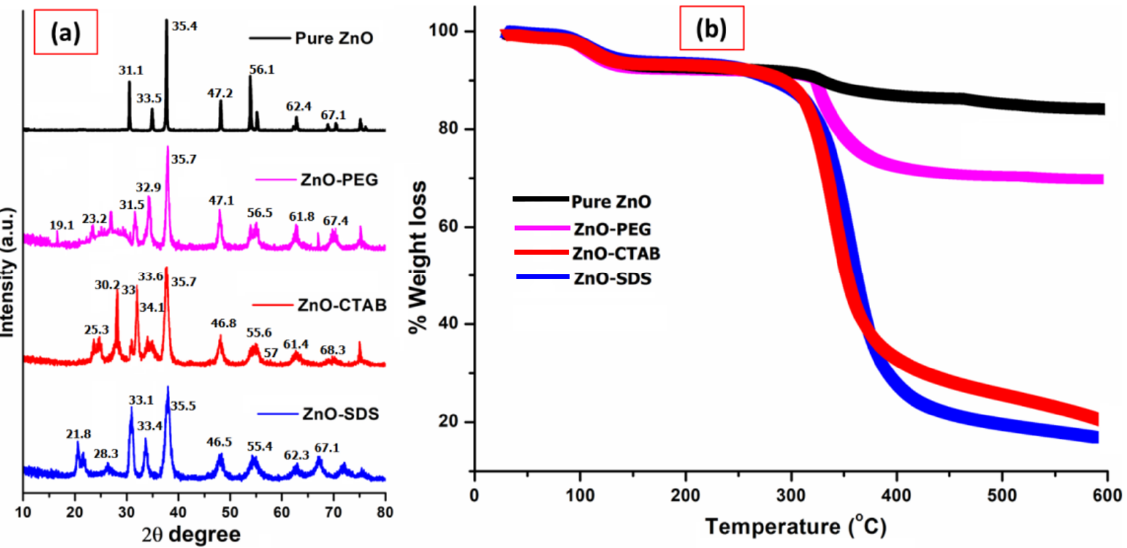
Figure 2. Comparison of ( a ) powdered XRD patterns and ( b ) TGA studies of all four ZnO NPs. The XRD pattern of ZnO–CTAB shows an increase in the diffraction peaks intensity at (100) and (002) but also a reduction in the peak intensity for the diffraction plane at (102), (110), (103), and (112) compared to pure ZnO NPs. Similar observations were reported by Rahman et al. [39] on the growth orientation of the crystal plane at three dominant peaks, i.e., the (100), (002), and (101) planes for a ZnO NPs crystal, followed by CTAB addition. Furthermore, as mentioned earlier, ZnO is a polar crystal consisting of Zn 2+ and O 2 − anions. On the other hand, CTAB is a cationic surfactant (CTA + and Br − ions) that can electrostatically form ion pairs CTA + [Zn (OH) 4 ] 2 − [40]. This chemistry was reported for the ZnO–SDS sample, some studies reported the effectiveness of SDS in the formation of a bare crystalline phase by acting as a growth template in the functionalization of ZnO NPs [42]. Since SDS has S=O groups that could act as proton receptors, and, in aqueous solution, they ionize into Na + (S) and CH 3 (CH 2 ) 11 OSO 3 − (DS − ). The formed ions in contact crystalline particles [42]. Ahson et al. (2020) observed that the hydrothermal growth with SDS favored the formation of small crystalline ZnO NPs, i.e., the bare polar planes of ZnO favor the formation of more oxygen vacancies [43]. The electrostatic attraction among the groups of ZnO and SDS with their negatively charged sulfate groups inhibits the potential